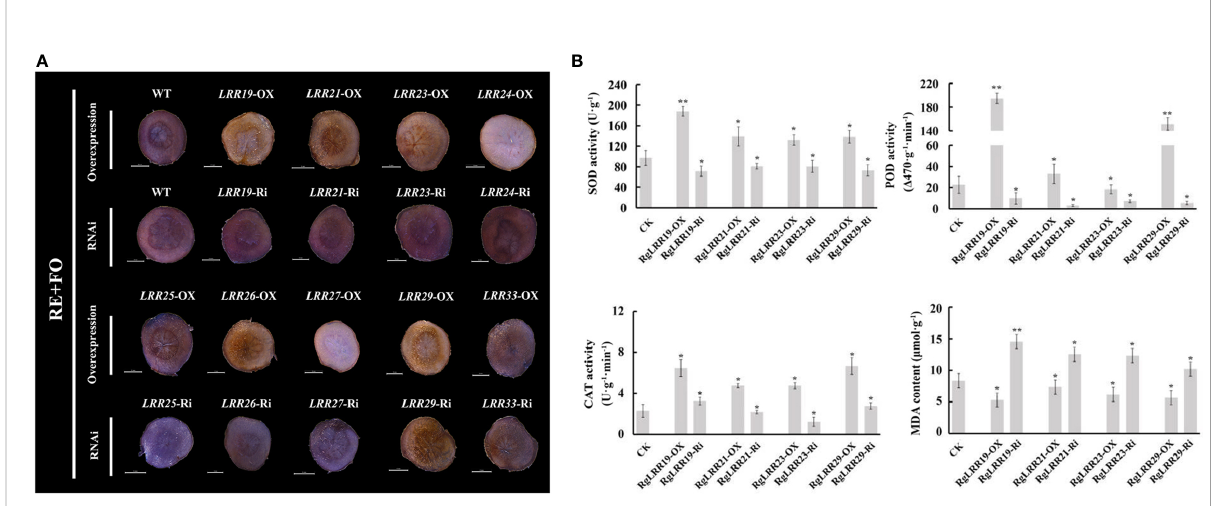
FIGURE 6 Changes of root segments with transient overexpression and RNAi of nine RgLRRs under comprehensive treatment of root exudates and F . oxysporum (A) , Trypan blue staining of root segments with transient overexpression and RNAi of nine RgLRRs under comprehensive treatment of root exudates and F . oxysporum ; (B) , The physiological indexes analysis of root segments with transient overexpression and RNAi of crucial RgLRRs under comprehensive treatment of root exudates and F . oxysporum . OX, Overexpression; Ri, RNA interference; CK, Empty vector as control; RE+FO, the comprehensive treatment of root exudates and F . oxysporum . Asterisks indicate signi fi cant difference compared with the corresponding controls (*, P < 0.05; **, P <